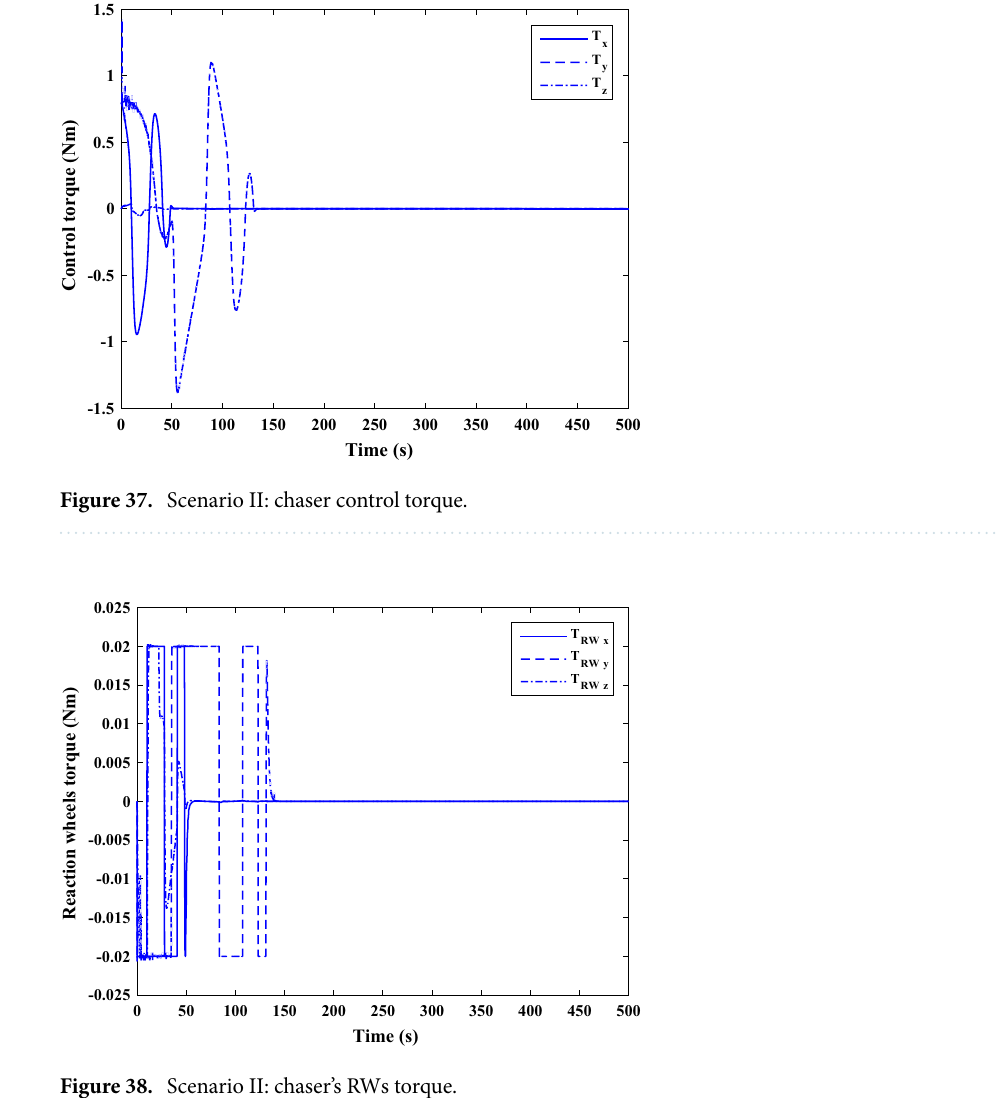
Figure 38. Scenario II: chaser’s RWs torque.